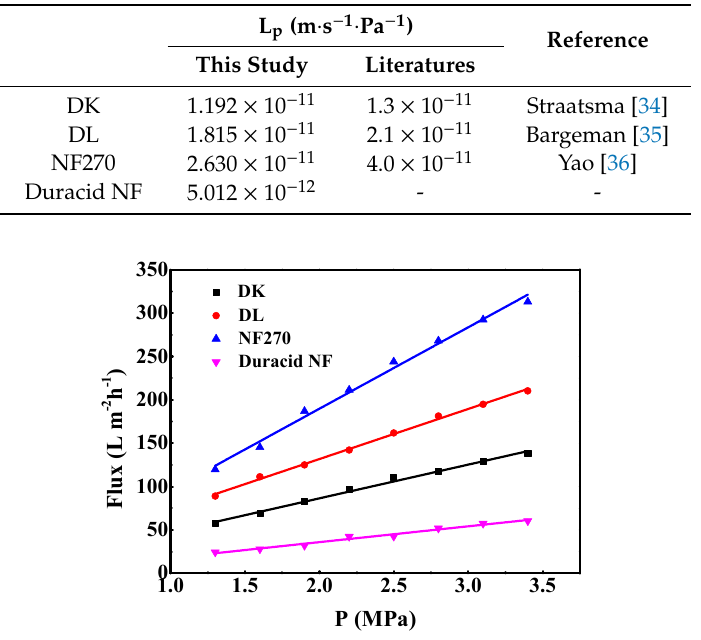
Figure 8. Permeate flux of pure water of four commercial NF membranes with different operation pressure.